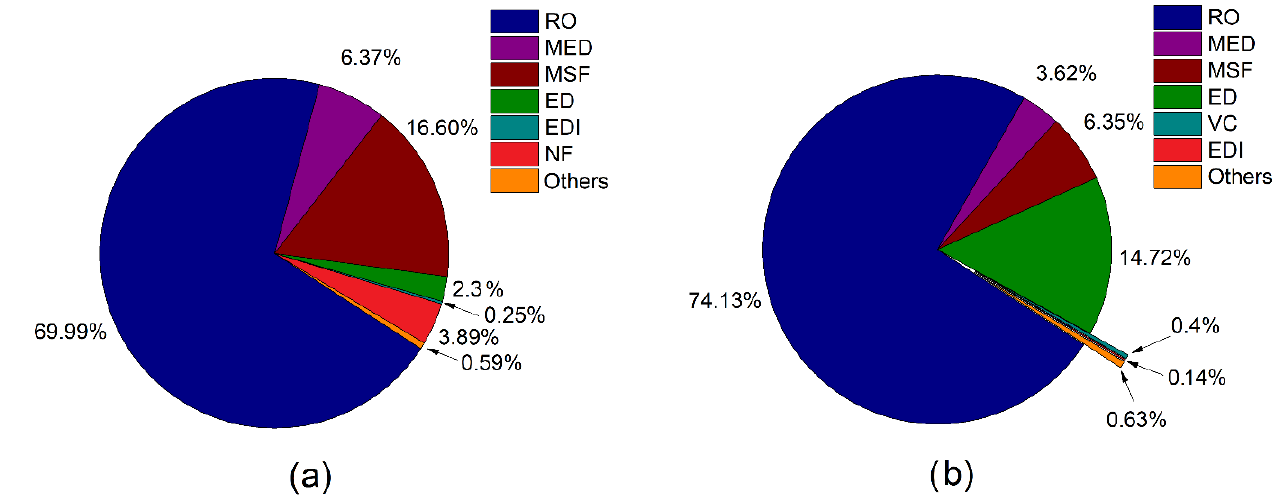
Figure 4. Percentages of installed capacity by technology: ( a ) worldwide; ( b ) México [8].